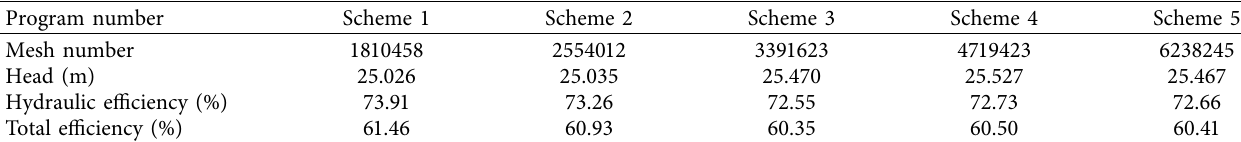
Figure 4: y + diagram of the impeller boundary. Table 3: Mesh independence check.